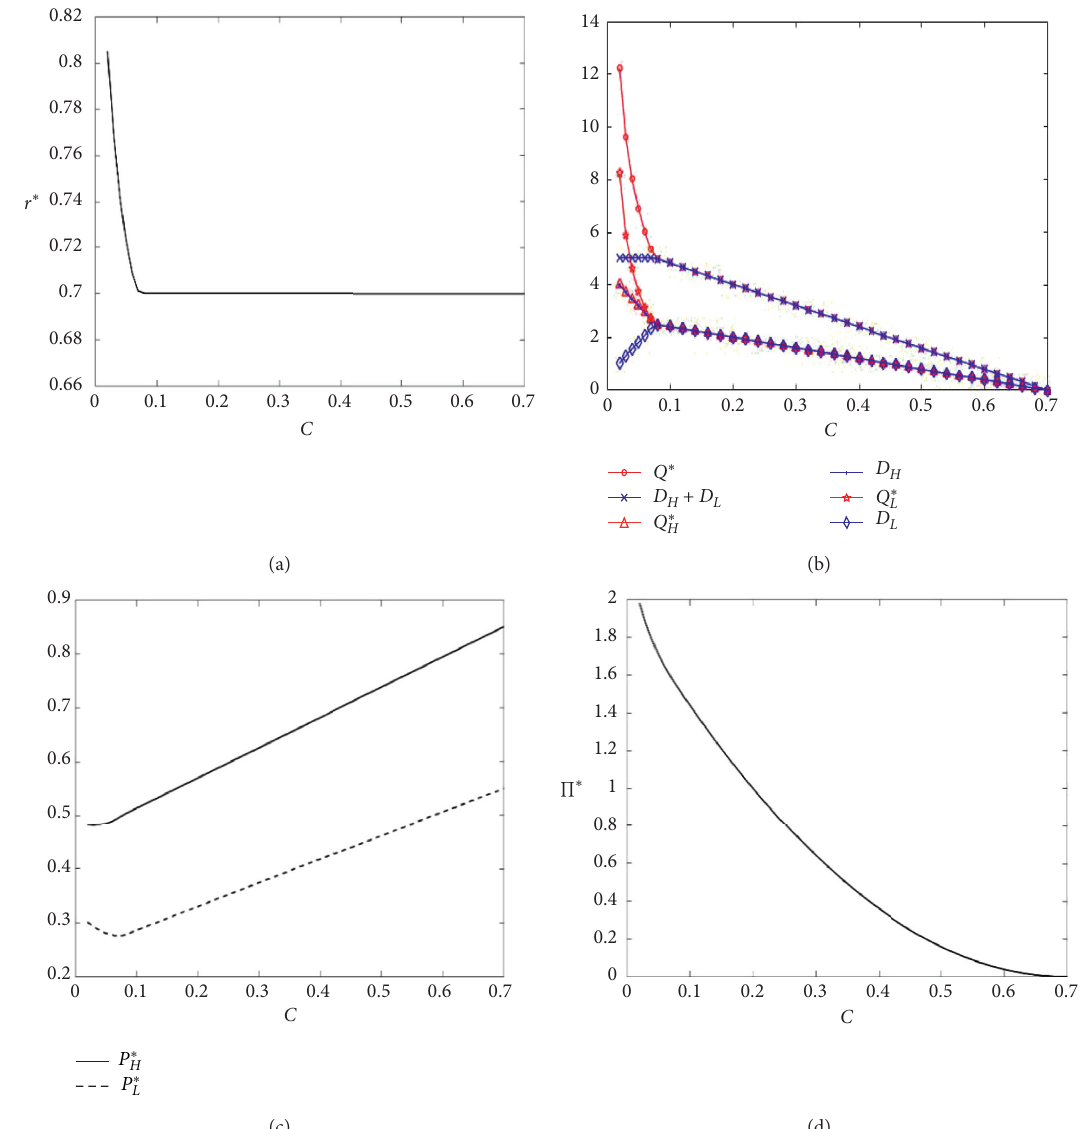
Figure 7: The influences of unit cost C on the retailer’s optimal decisions. (a) The influence of C on r , (b) the influence of C on D and Q , (c) the influence of C on P , and (d) the influence of C on Π